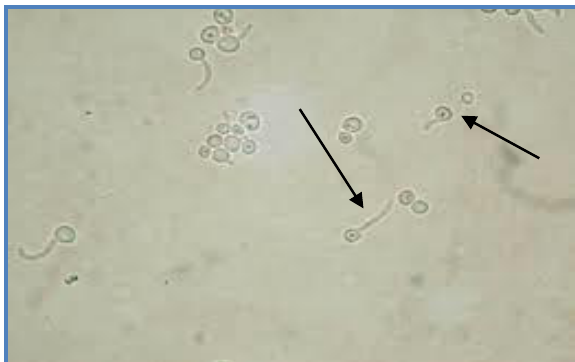
Figure, 3: Germ tube of candida albicans .